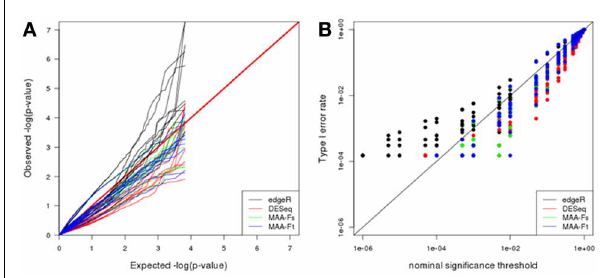
FIGURE 6 | Plasmode results from Cheung dataset: (A) Q-Q uniform plot of non-differentially expressed transcripts, (B) type I error rate vs. nominal significance values. Models: (1) edgeR (blue), (2) DESeq (red), (3) MAA-Fs: MAANOVA Fs moderated test using permutation (green), and (4) MAA-F1: MAANOVA F1 transcript by transcript test using permutation (blue).